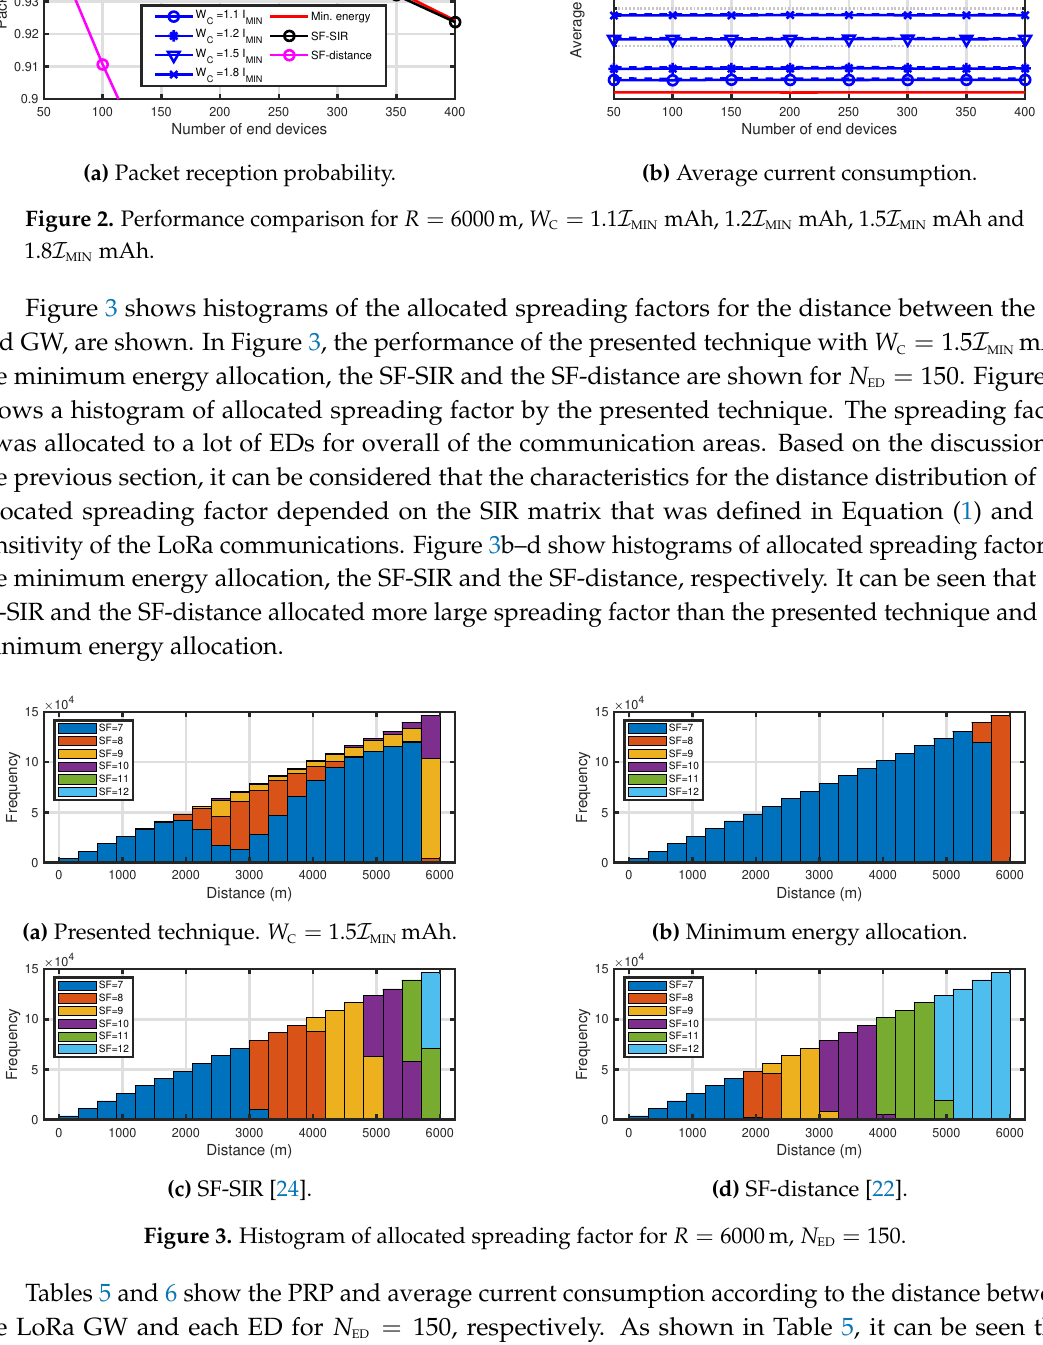
Figure 3. Histogram of allocated spreading factor for R = 6000m, N